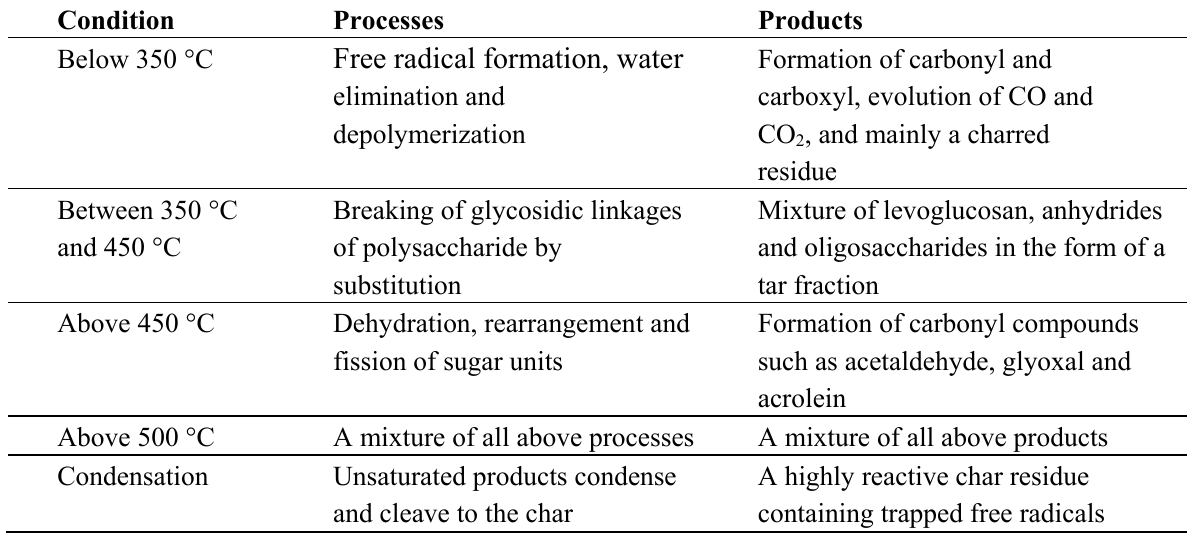
Table 6. Pyrolysis reactions at different